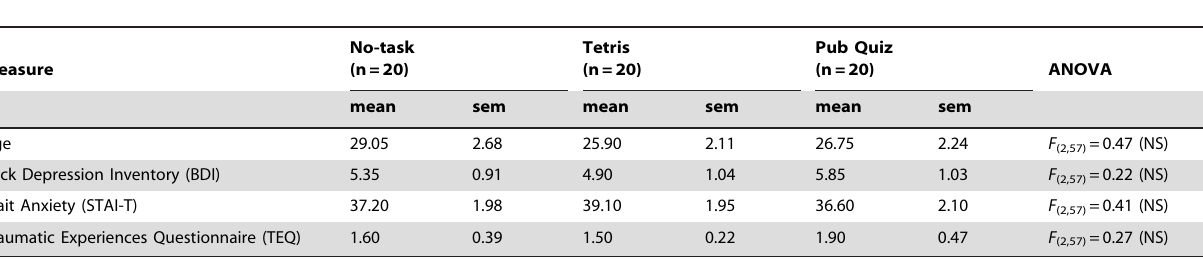
Table 1. Experiment 1 means and statistics for age and baseline assessments indicating experimental conditions did not differ.